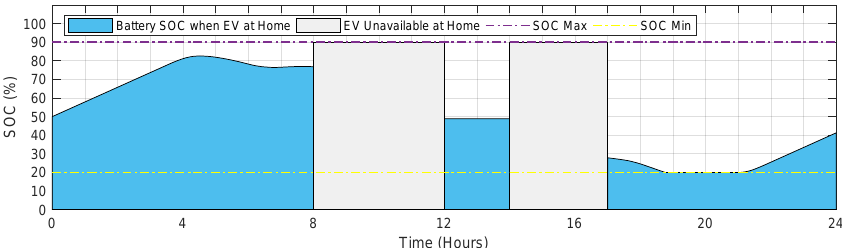
Figure 9. State of charge curve of EV when the proposed strategy is used to managing the energy in a smart home equipped with EV without PV.